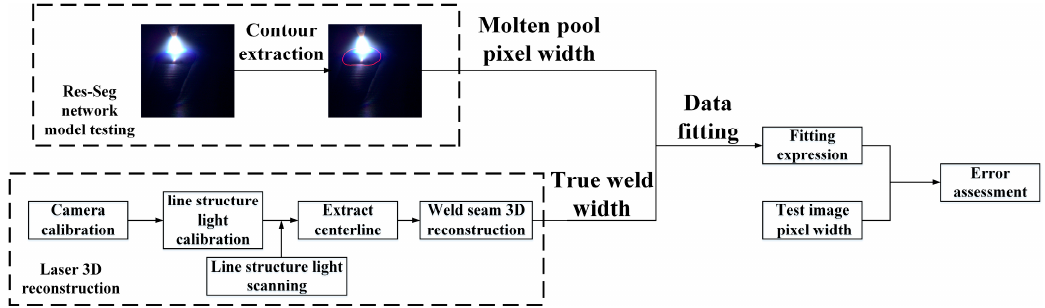
Figure 12. Flow chart of weld seam width verification.